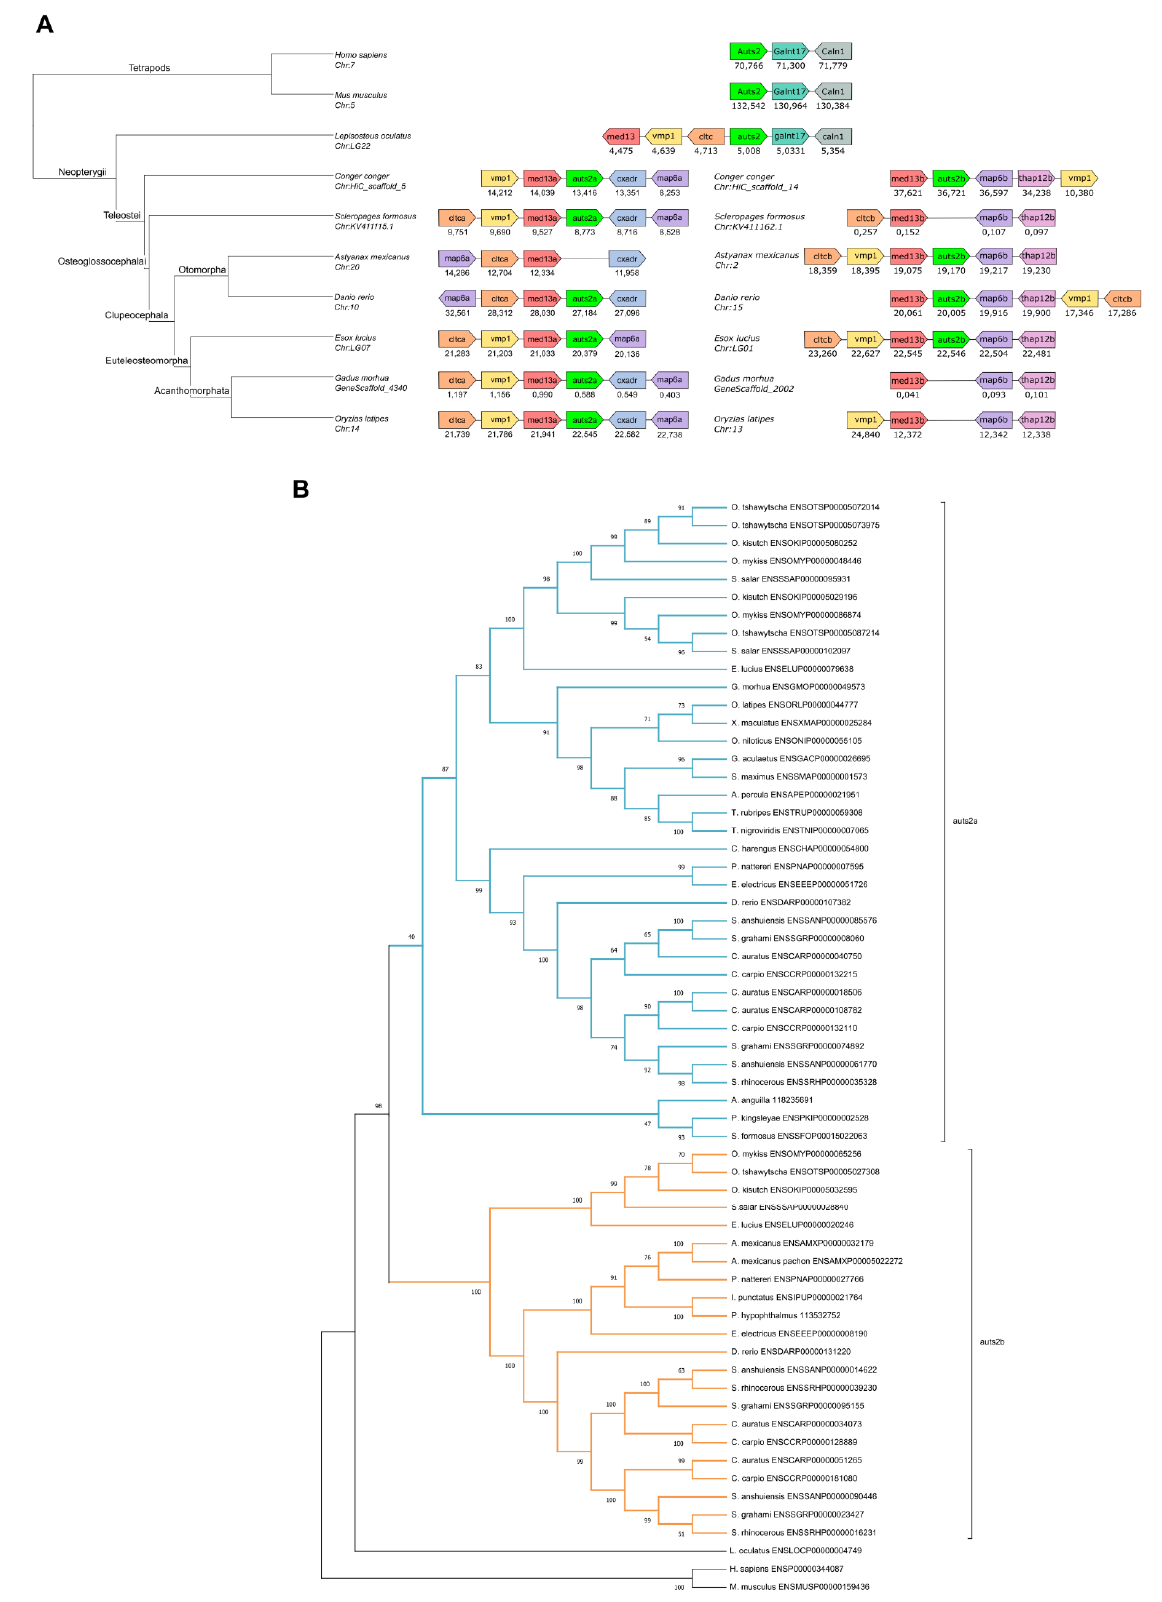
Figure 1. Identification of teleost auts2 ohnologs and their origin using synteny and phylogenetic anal- ysis ( A ). Identification of teleost auts2a and auts2b in 7 species using synteny analysis.